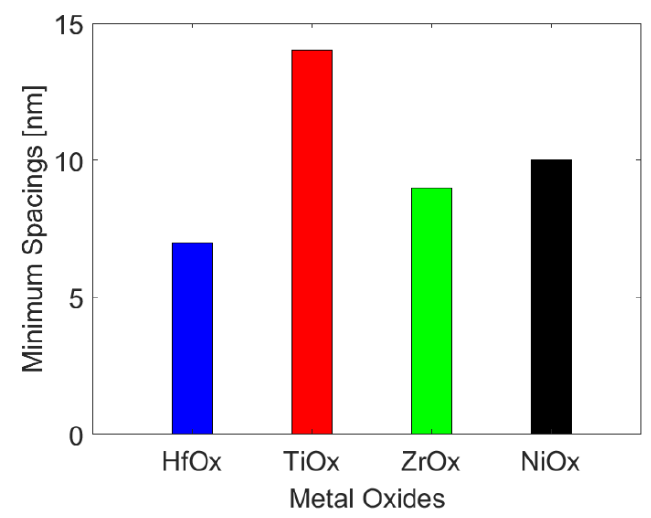
Figure 10. The minimum spacings between adjacent conduction filaments to avoid device failure in Pt-RRAM arrays with different metal oxides.